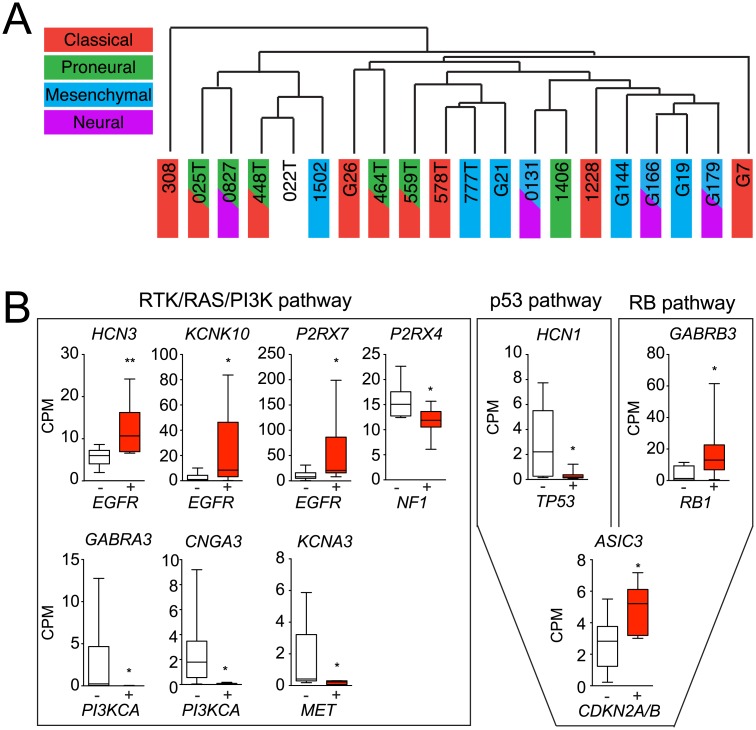
GSC-enriched ion channels are associated with GBM molecular features.A. Hierarchical clustering of GSCs by molecular subtype based on CPM values of all 266 ion channels. B. Correlation of IGCs with gene mutation signatures of critical GBM signaling pathways (see S1 Table for details). Bars, mean ± min/max, IQR. Two-tailed Mann-Whitney test; *p<0.05, **p<0.01.